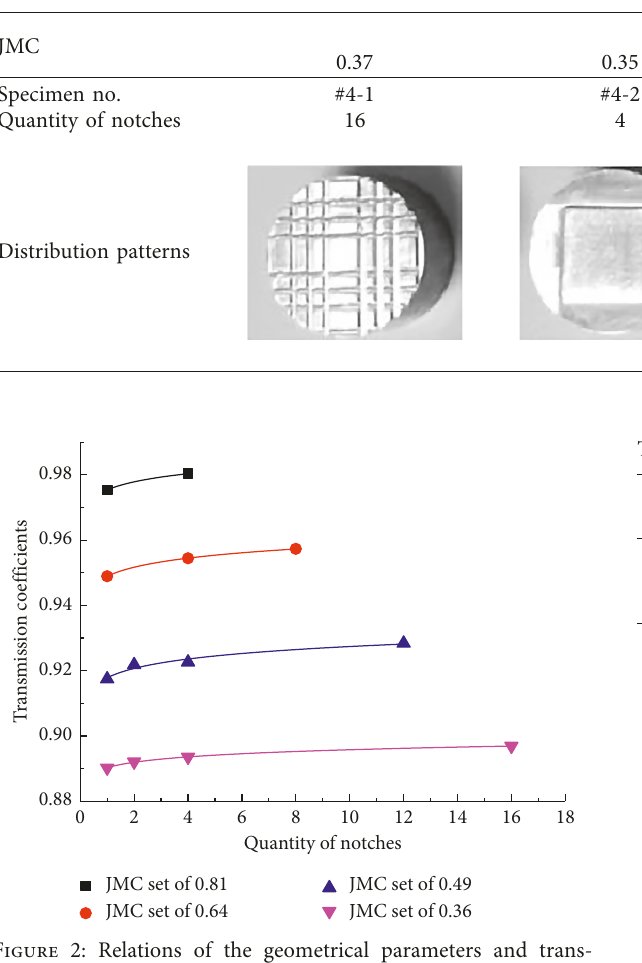
Table 5: Geometrical parameters of the specimens: #Set 4.